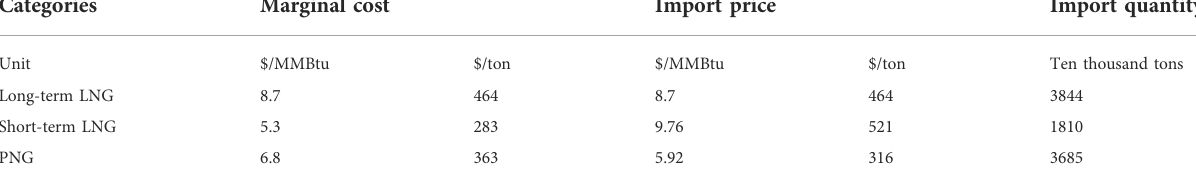
TABLE 1 Characteristics of China ’ s natural gas imports in